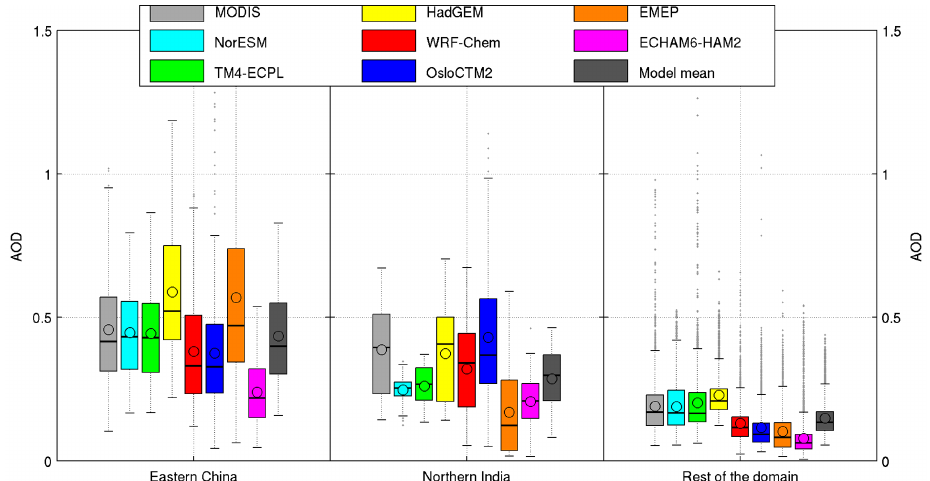
Figure 9. Box plots showing the mean AODs (circle), median (central line), the 25th and 75th percentiles (box edges) and the extreme data not considered as outliers (whiskers) during August and September 2008, as observed by MODIS and simulated by the ECLIPSE models over northern India, eastern China and the Asian domain.